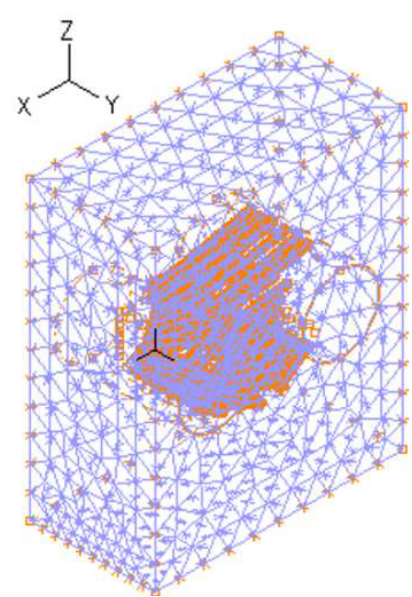
Figure 2. Geometric model and meshes of soil and tunnel (unit: mm).